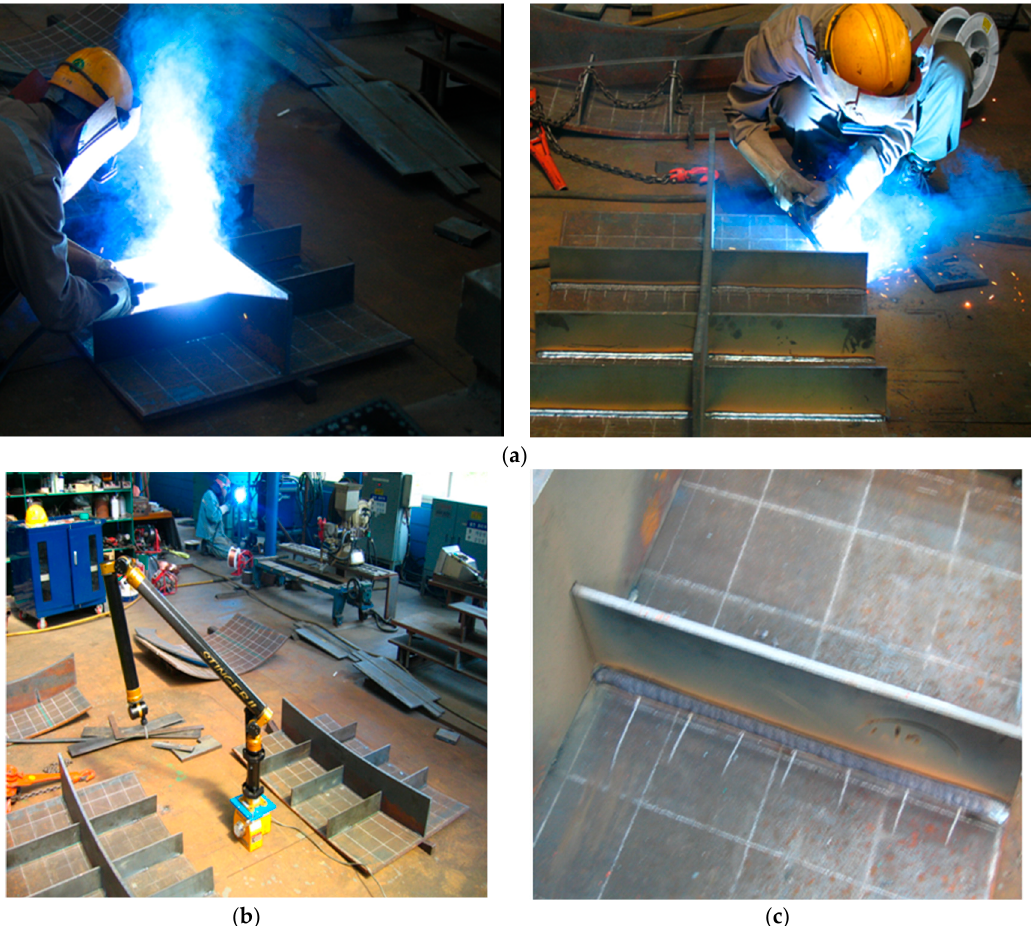
Figure 11. Experiments for welding deformation: ( a ) welding experiment, ( b ) structure after welding, ( c ) bead at the weld.